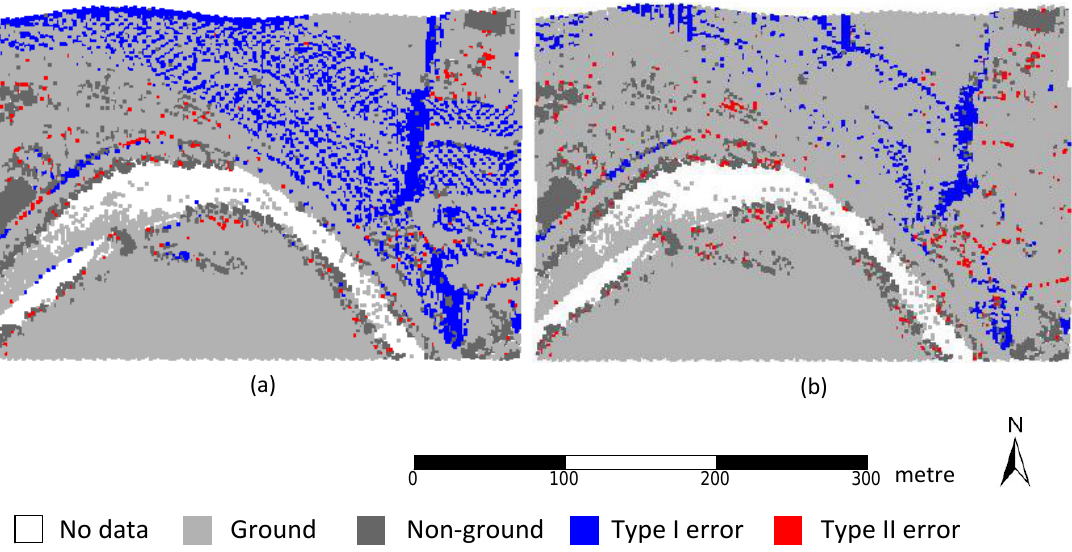
Figure 10. Comparison of results of filtering Sample 52: ( a ) results of Li et al. [44]; and ( b ) results of this proposed method.